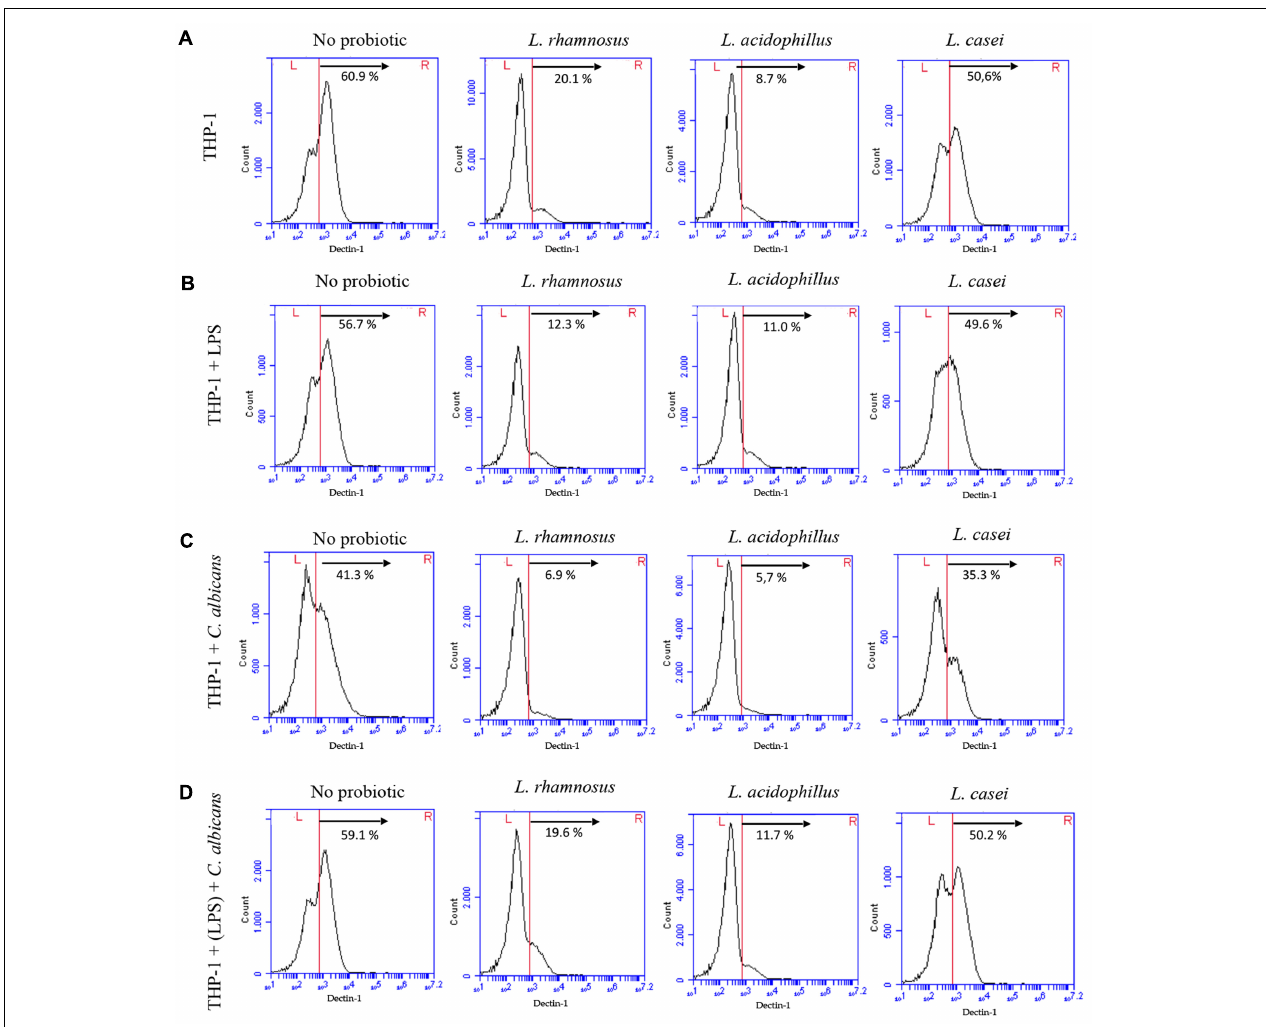
FIGURE 5 | Expression of dectin-1 receptors by THP-1 macrophages in control groups (no probiotic pretreatment) and test groups (pretreated with L. rhamnosus LR32, L. acidophilus NCFM, or L. casei L324m) determined by flow cytometry. (A) Macrophages pretreated with probiotic bacteria; (B) macrophages pretreated with probiotic bacteria and challenged with LPS; (C) macrophages pretreated with probiotic and challenged with C. albicans ; (D) macrophages pretreated with both LPS and probiotic before C. albicans challenge. Percentage of cells expressing high levels of dectin-1 is shown for each